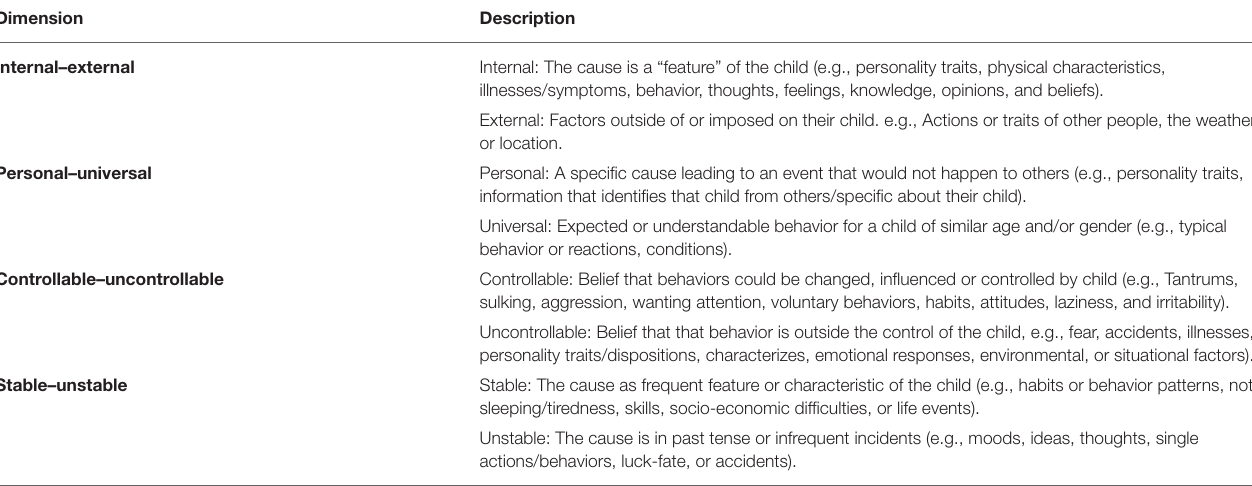
TABLE 1 | Attribution dimensions.